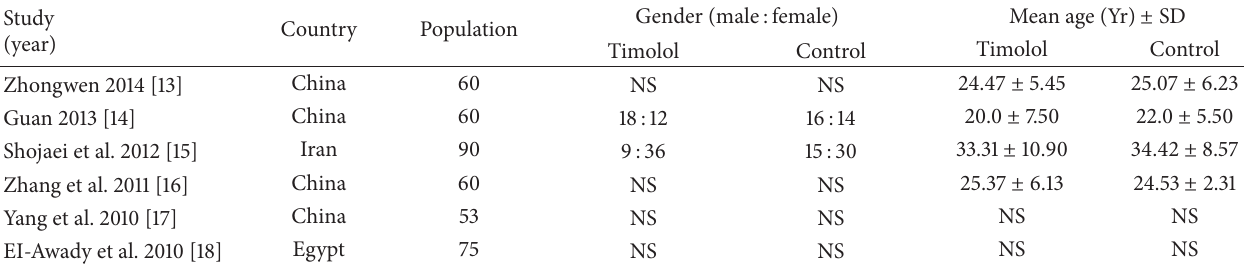
Table 1: Demographic characteristics of eligible studies.